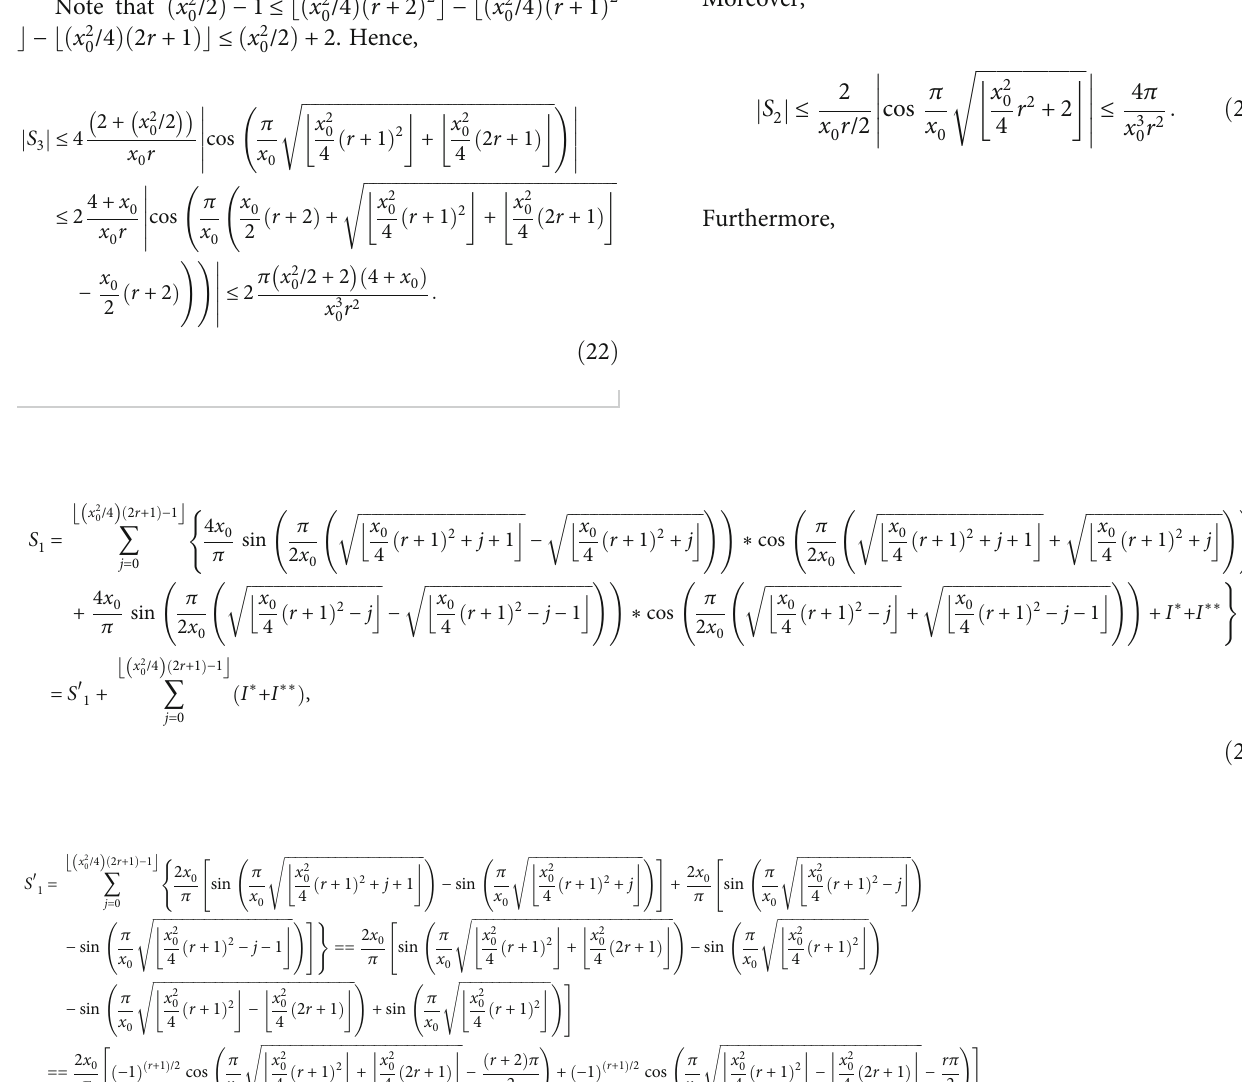
ffiffiffiffiffiffiffiffiffiffiffiffiffiffiffiffiffiffiffiffiffiffiffiffiffi x 2